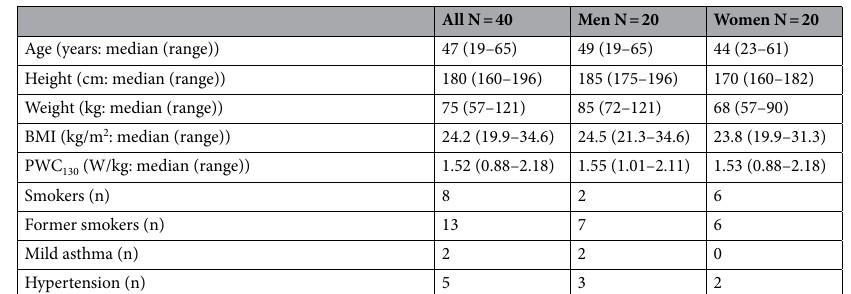
Table 1. Characteristics of the study participants (median and range). BMI Body-mass index, PWC 130 Physical working capacity at a heart rate of 130 beats per minute.